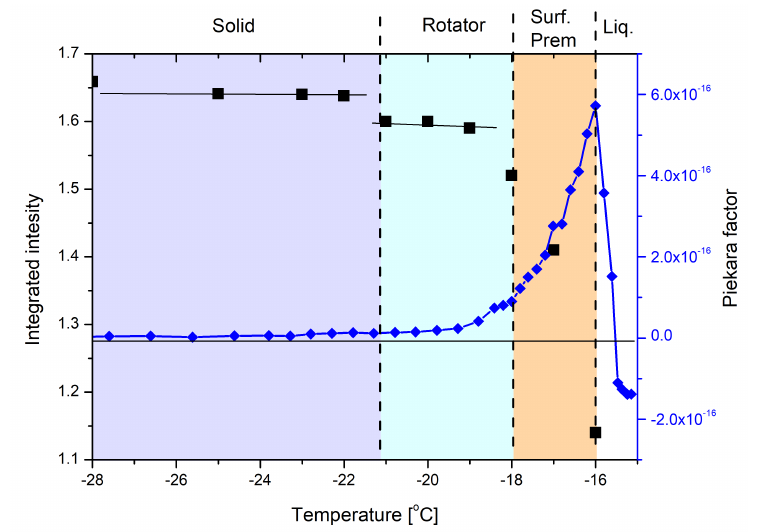
Figure 5. Comparison between temperature evolution of integrated intensity of the CH 2 rocking vibrations region (black) and the NDE results, given as Piekara factor